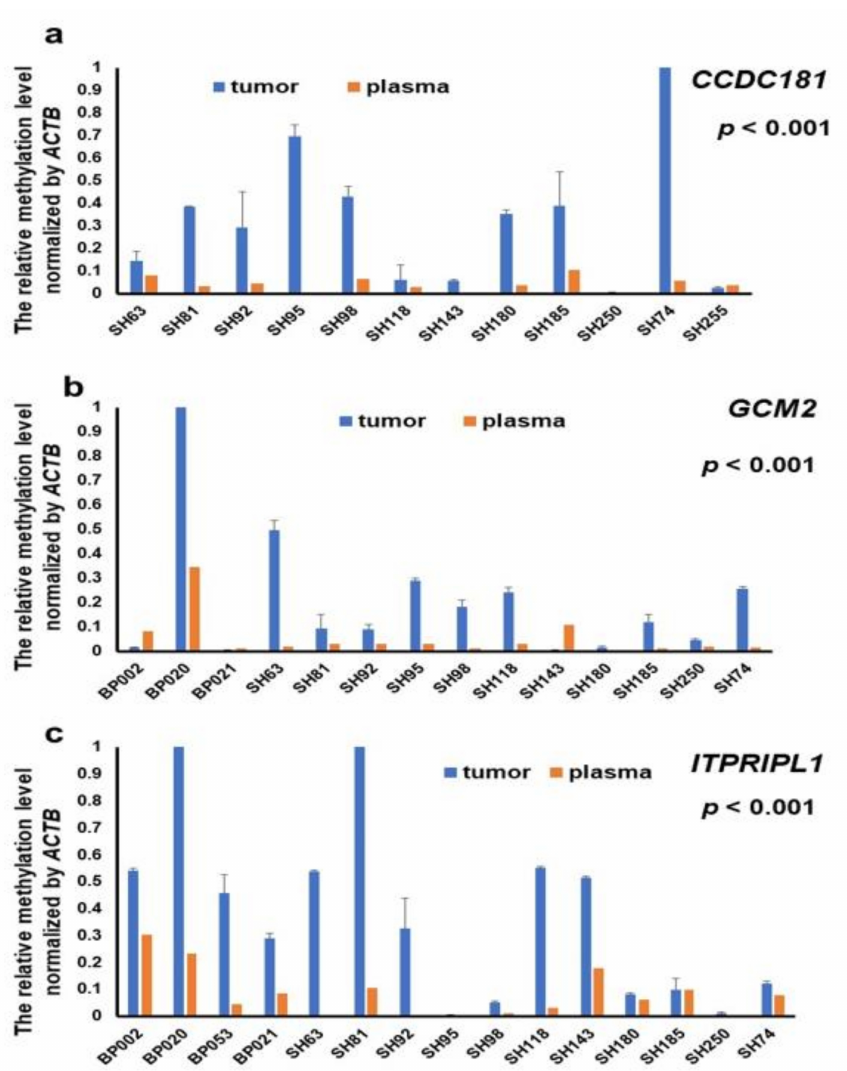
Figure 5. Consistency of the methylation levels of CCDC181 , GCM2 and ITPRIPL1 between tissues and plasma in the same patients are shown. Representative figures of the target gene methylation levels determined by qMSP in BC tumor tissues and matched plasma in the same BC patients. Experiments were performed with three technical replicates. Bar charts for CCDC181 ( a ), GCM2 ( b ), and ITPRIPL1 ( c ) are shown. A Spearman’s rank correlation was used to calculate the correlation between two